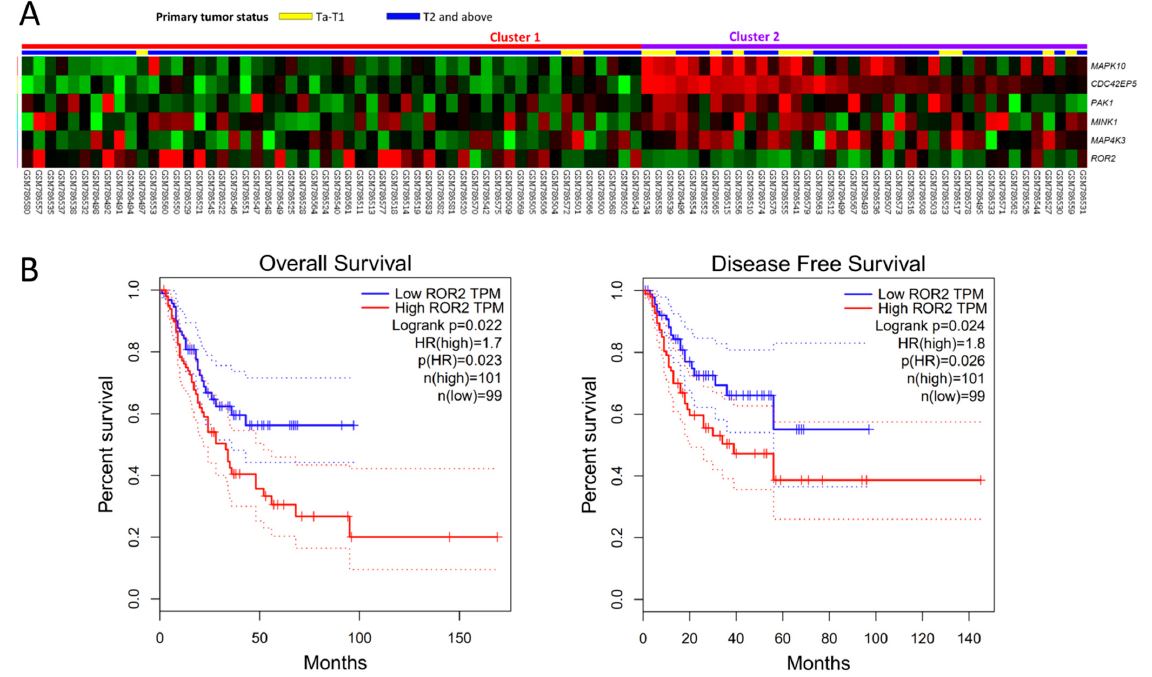
Figure 1. Transcriptomic profiling and survival analysis. ( A ) Expression profiles of genes associated with the progression of UBUC (T2-4 vs. Ta-1) focusing on JNK cascade from a published transcriptome (GSE31684) in Gene Expression Omnibus. ROR2 is the most significantly upregulated gene. ( B ) Using GEPIA databases, high ROR2 expression was remarkably related to worse overall survival ( p = 0.022) and disease-free survival ( p = 0.024) in UBUC.